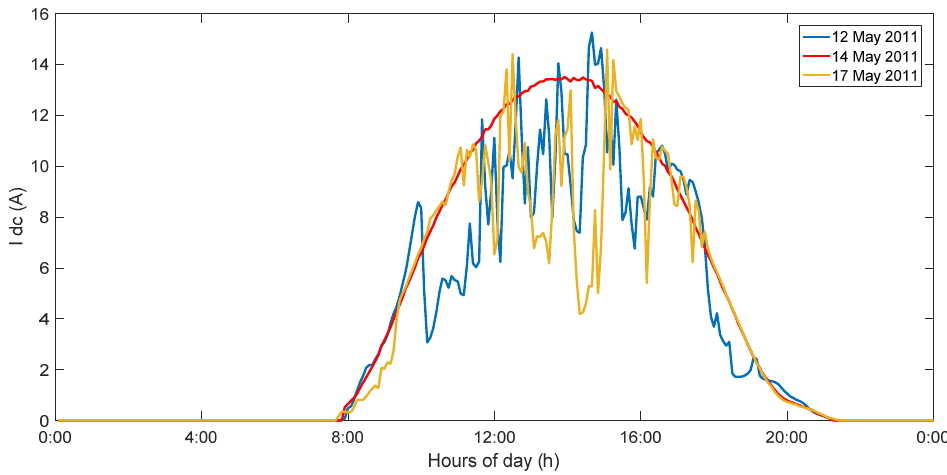
Figure 13. Daily profiles of the direct current, I dc , produced in the set of 36 PV modules during 12, 14 and 7 May 2011.